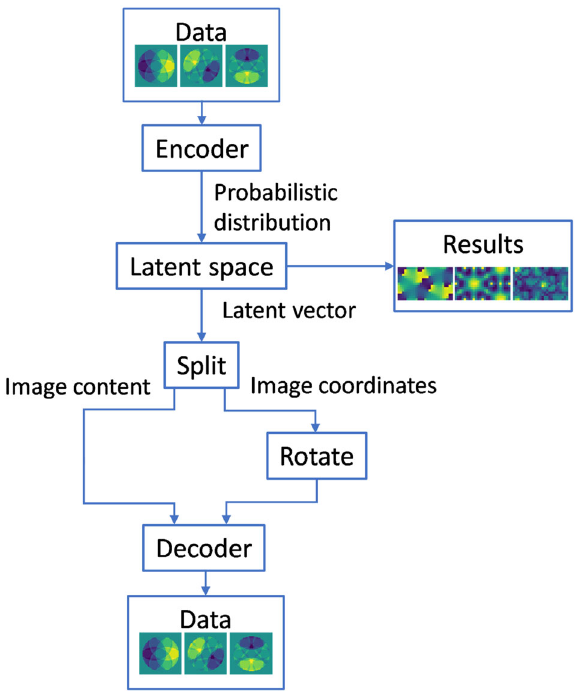
Fig. 1 Graphical representation of the rrVAE algorithm. An illustration of the encoding/decodong process as discussed in detail in the